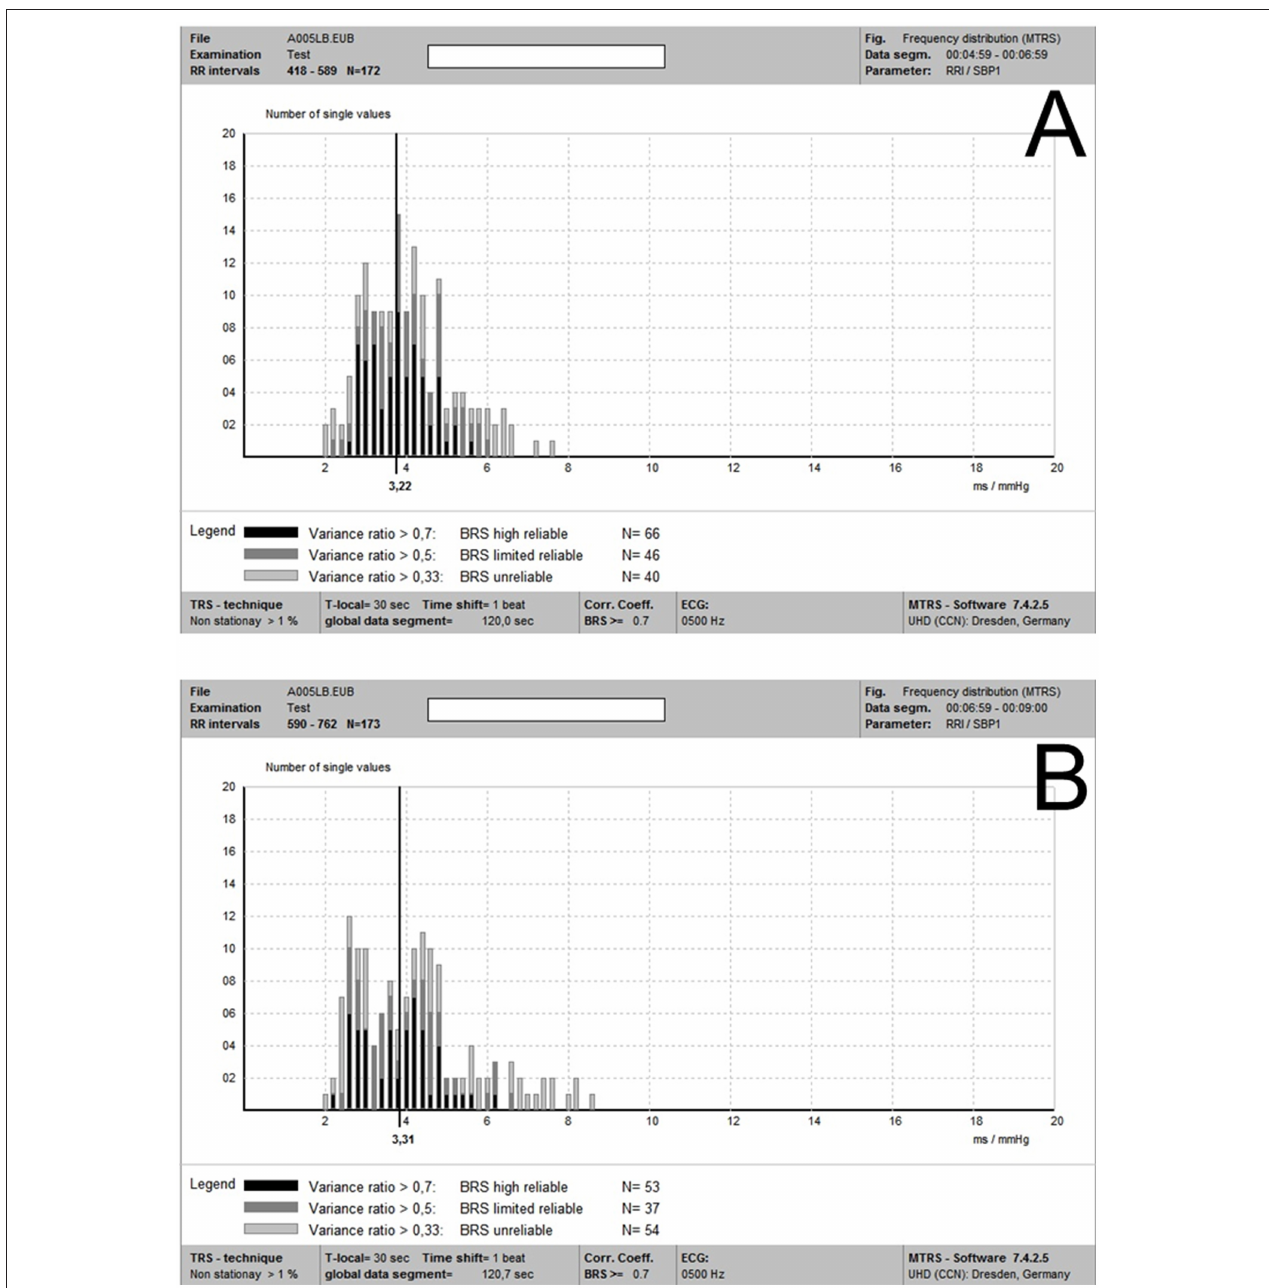
FIGURE 2 | (A , B) Individual BRS-values within two different 2-min global data segments (2a and 2b, respectively) in the same recording. It is noted that although there was some degree of variability of individual local BRS-values between these two global data segments, these two mean global BRS-values were quite close.